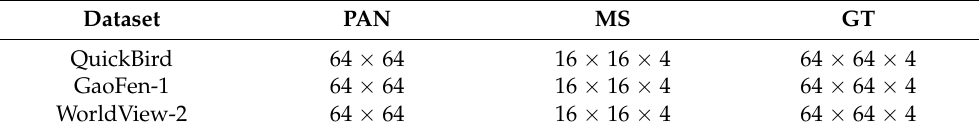
Table 2. Size of PAN image, MS images, and GT images for GaoFen-1, QuickBird, and WorldView-2.